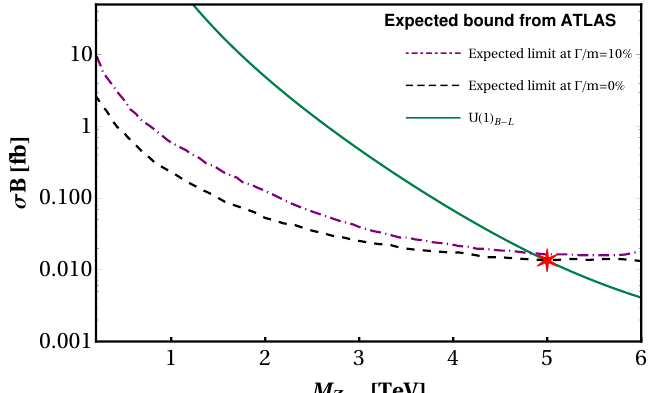
Figure 2. Constraints from σB coming from di-leptonic final state at the LHC with the centre of mass energy of 13 TeV and luminosity of 139 fb − 1 [43]. The black dashed and purple dot-dashed lines are for expected limits on the cross-section, at the relative width-signals of zero and 10% , respectively. The green line represents the theoretical prediction of U(1) is the chosen benchmark point for the collider study.